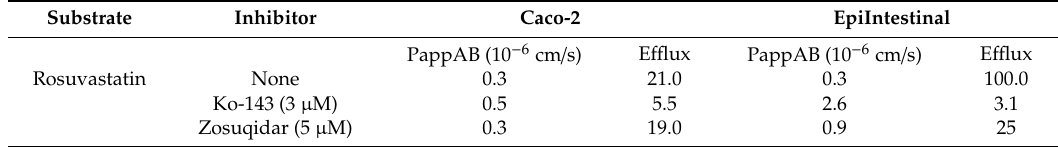
Table 3. Inhibition of transporter-mediated e ffl ux of rosuvastatin in Caco-2 and EpiIntestinal microtissues. Data are mean values of duplicates (Caco-2) or triplicates (EpiIntestinal microtissues).